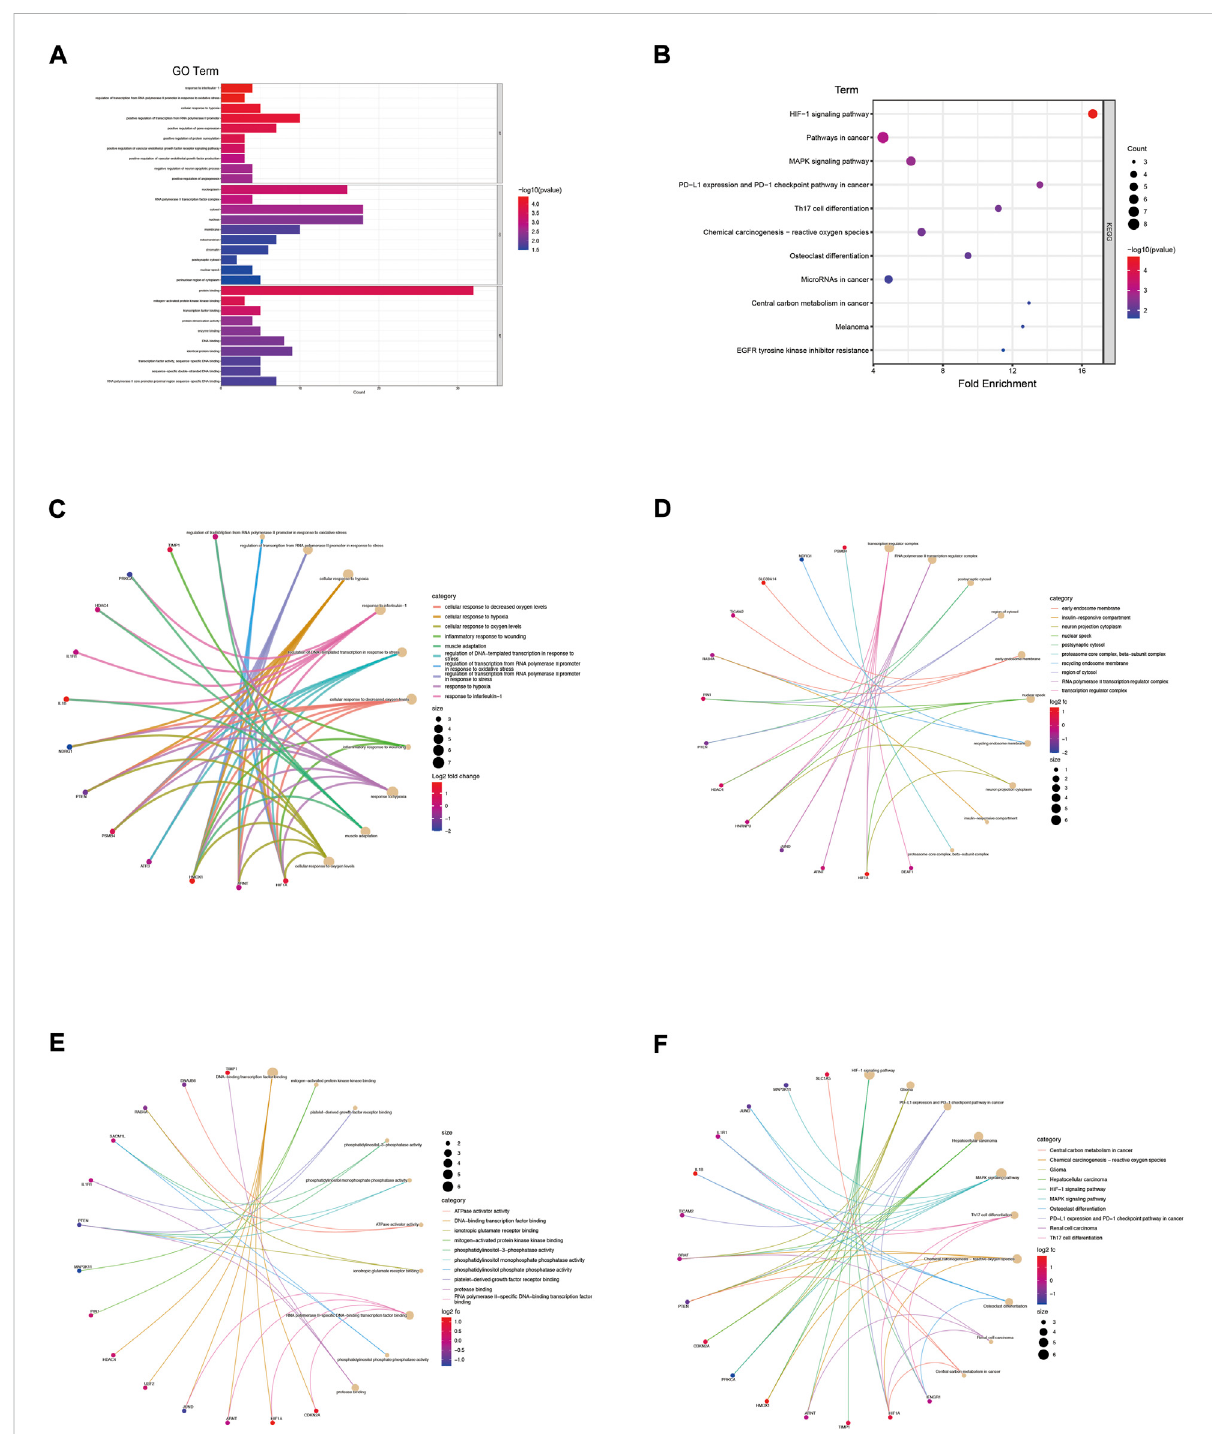
FIGURE 3 Enrichmentanalysisofgenesinco-expressionPPInetworks. (A) GOenrichmentanalysis ofthese genes. (B) KEGGenrichmentanalysis ofthese genes. (C) The category of “ biological process ” of these genes was displayed by chord diagram. (D) The category of “ cellular component ” of these genes was displayed by chord diagram. (E) The category of “ molecular function ” of these genes was displayed by chord diagram. (F) The KEGG pathway enrichment analysis of these genes was displayed by chord